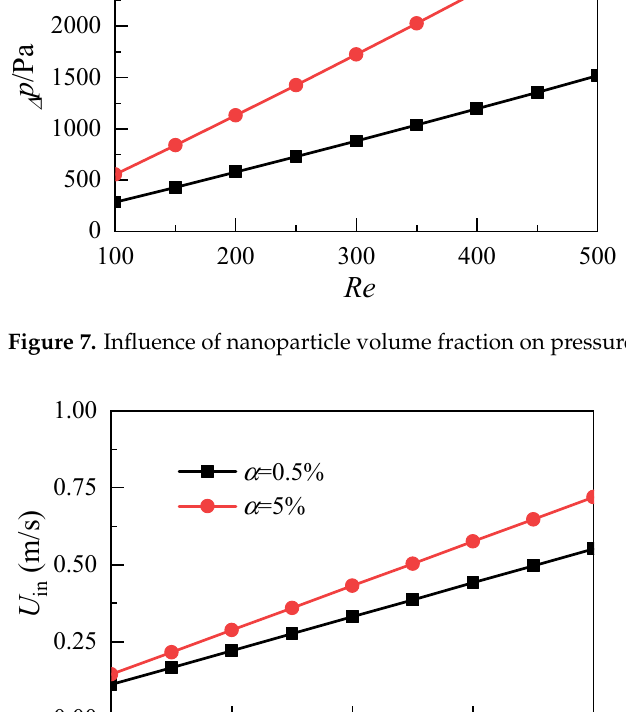
Figure 9. Effects of nanoparticle volume fraction on pumping power. 3.2. Influence of the Aspect Ratio of Microchannels This work studies nanofluids with a nanoparticle volume fraction of 5%. The differ- ent aspect ratios ( HW ) of microchannels can be obtained by changing their height ( W h ). The aspect ratios of the five microchannel heat sink models are 10, 20, 30, 40 and 50. A three-dimensional simulation of flow and heat transfer under different Reynolds numbers is conducted, and the flow and heat transfer characteristics of nanofluid microchannels with different aspect ratios are analyzed and compared. As shown in Figure 10, the